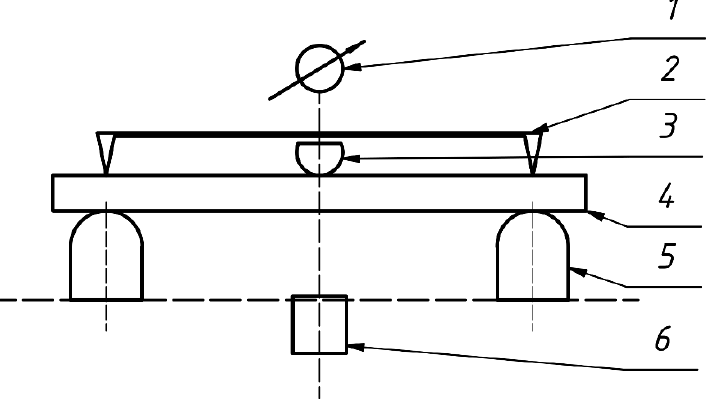
Figure 1. Scheme of prototype creep testing machine (1—micrometer; 2—deflectometr; 3—thrust; 4—sample; 5—suports; 6—load).